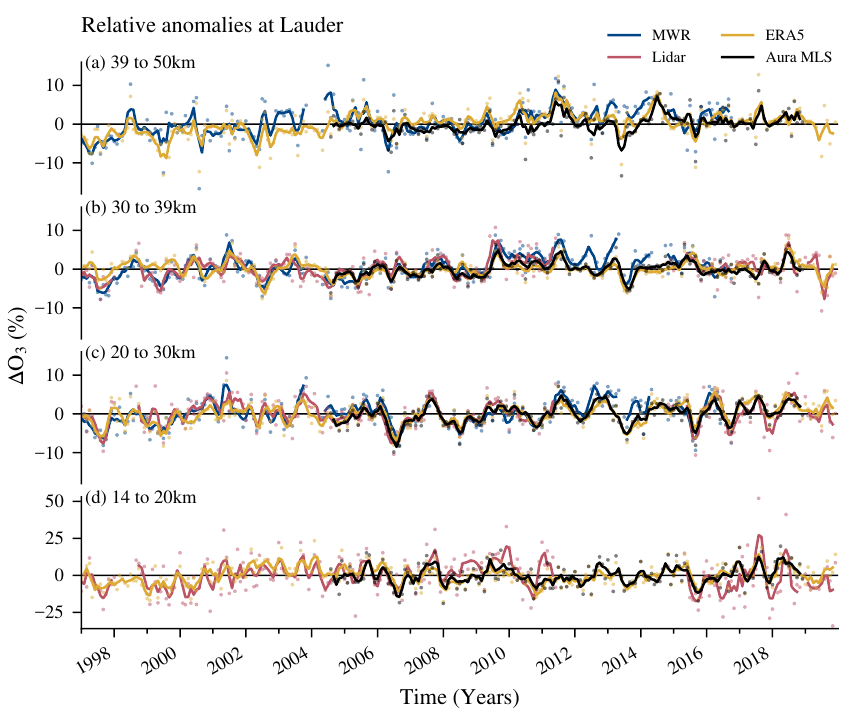
Figure 1. Relative anomalies of monthly ozone volume mixing ratio (VMR) at Lauder, New Zealand, for microwave radiometer (MWR), lidar, ERA5 reanalysis, and Aura MLS data. The relative anomalies (dots) show for each month the deviation from the monthly mean climatology (1997 to 2019). The bold lines show data smoothed with a moving window of three months. Relative anomalies are averaged over four altitude ranges, representing approximately ( a ) the upper stratosphere, ( b ) the upper-middle stratosphere, ( c ) the middle stratosphere, and ( d ) the lower